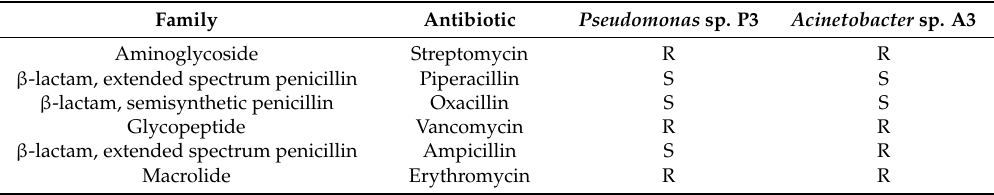
Table 6. Antibiotic sensitivities of the isolated